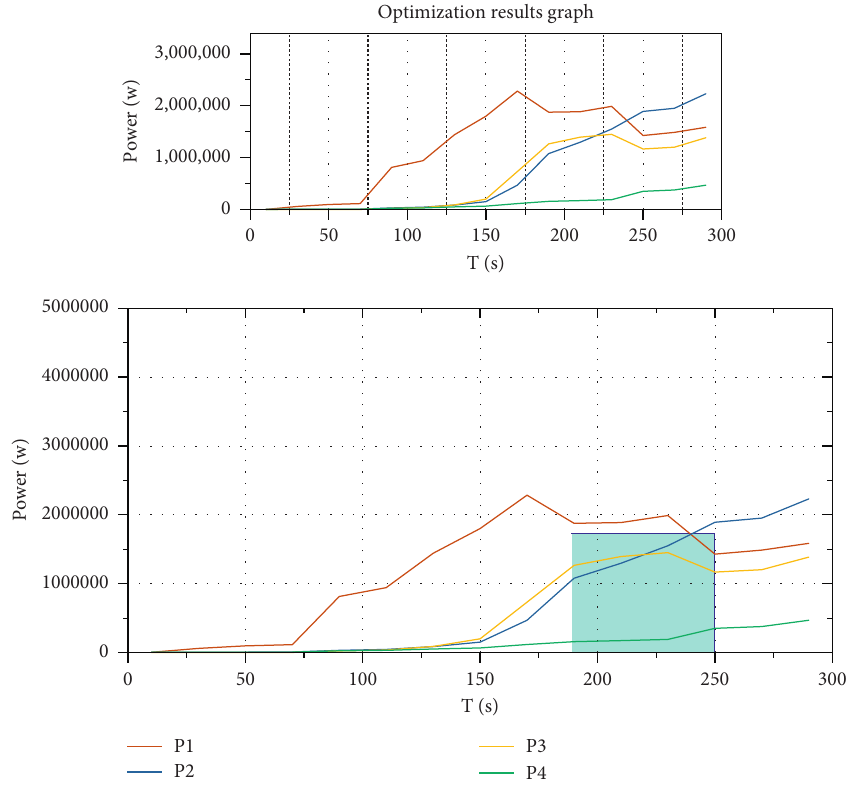
Figure 6: Data monitoring